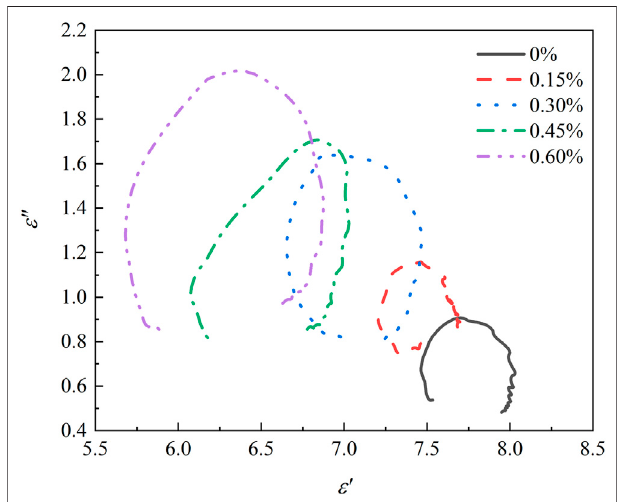
FIGURE 7 | Colo-colo graph.